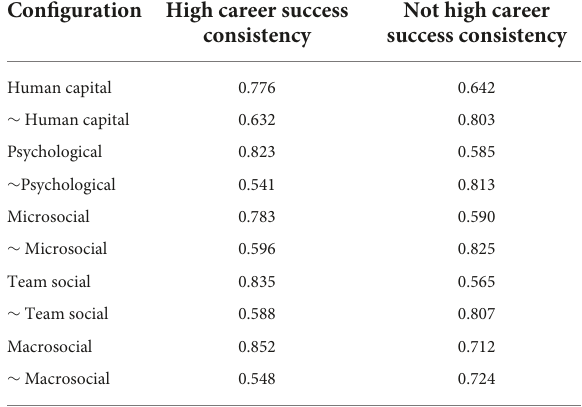
TABLE 4 Necessity test for the single requirement of QCA.